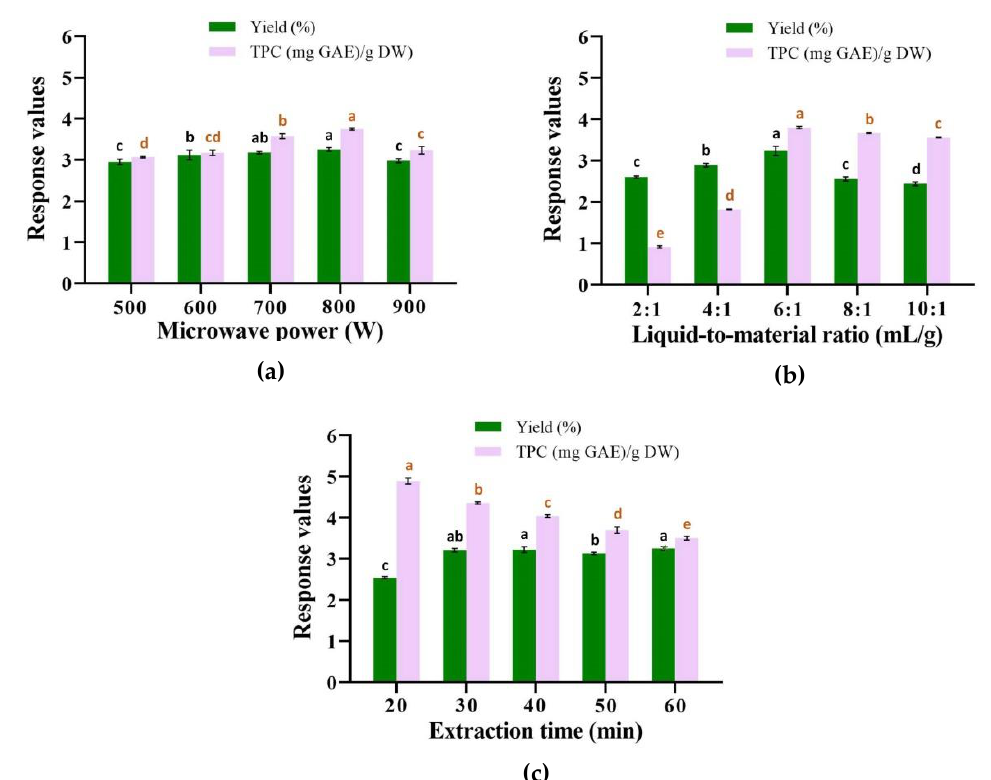
Figure 1. Effects of single factors on the yield of essential oil and content of total polyphenols in extract fluid: microwave power ( a ), liquid-to-material ratio ( b ), and extraction time ( c ). Different letters within a, b, c, and d in black color indicate significant differences ( p < 0.05) in the essential oil yield among groups; Different letters within a, b, c, d, and e in red color indicate significant differences ( p < 0.05) in the total phenol content (TPC) among groups. The same letter indicates no significant difference ( p > 0.05) among groups. The significant differences among groups were analyzed by one-way ANOVA with Duncan post hoc test at p < 0.05.